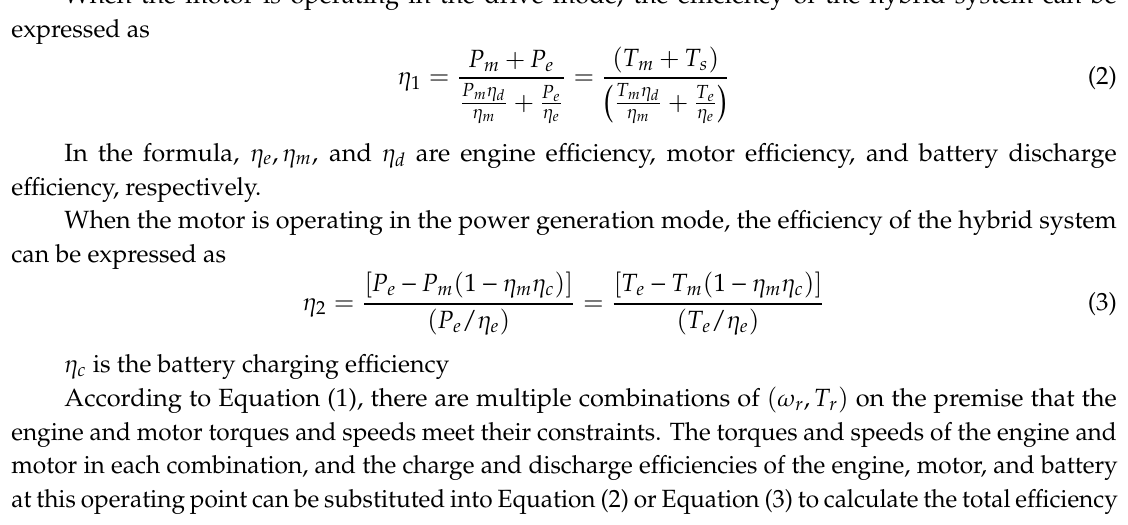
Figure 4. The optimal operating curve of the engine.